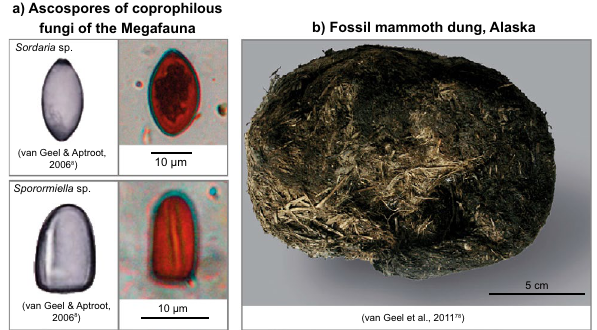
Figure 2. Ascospores of coprophilous fungi, ( a ) photos of spores in textbook 8 and in the ELSA-Stack samples, ( b ) fossil mammoth dung 78